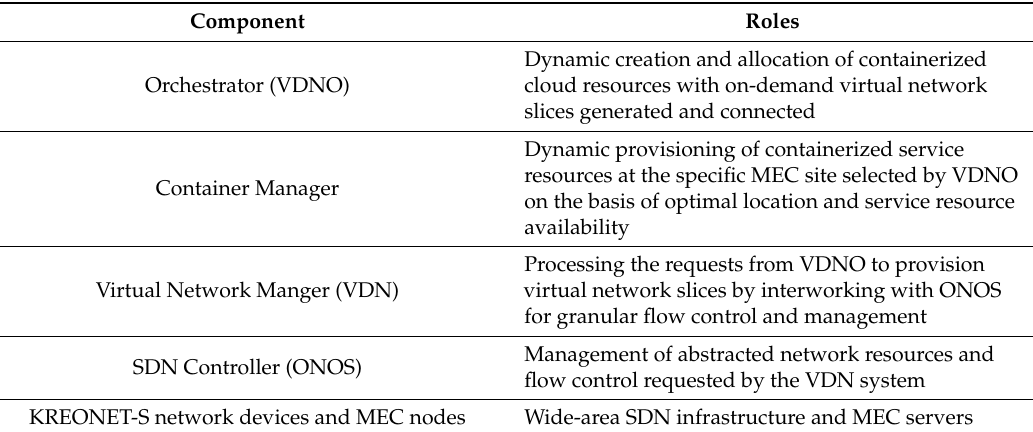
Figure 6. Integrated VDN orchestrator architecture and process. Table 1. VDNO components and roles. ONOS, Open Network Operating System.